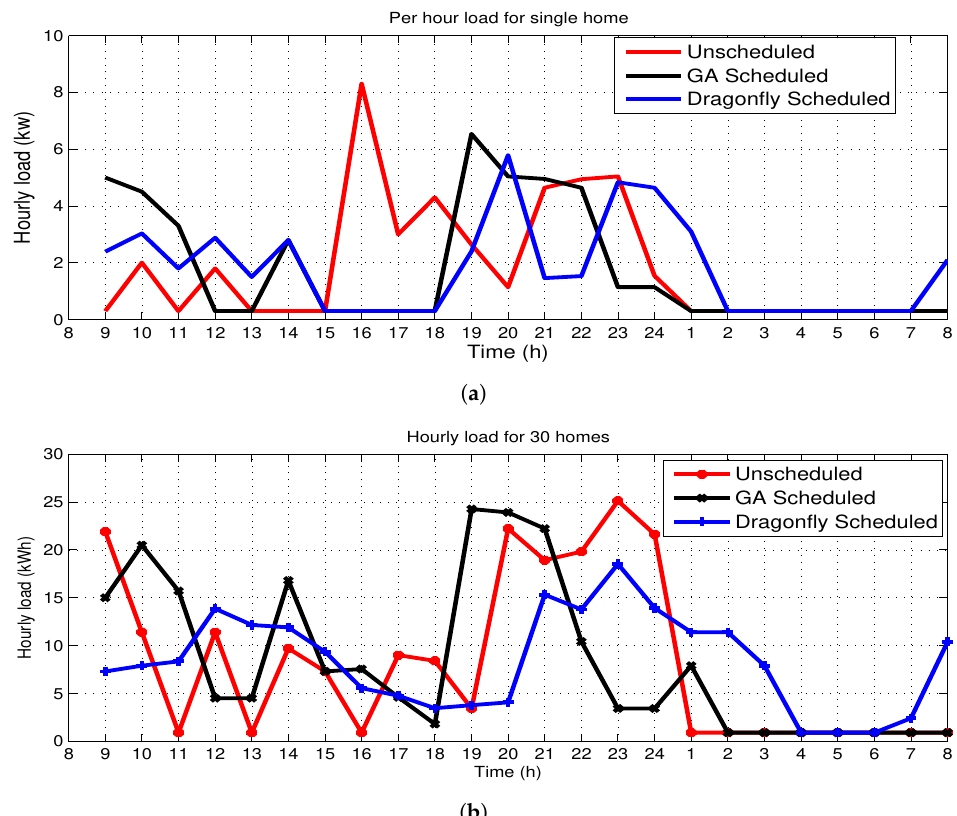
Figure 5. Daily basis hourly load for un-scheduled and GA and DA scheduled ( a ) single home; ( b ) 30